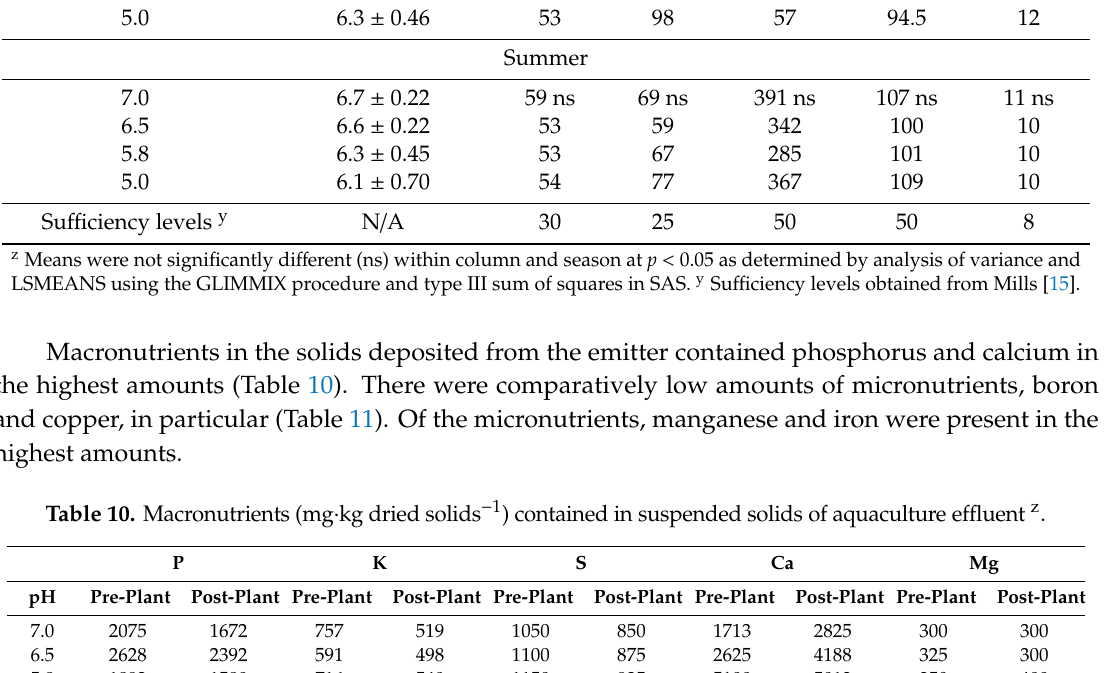
1892 z Solids were dried at 105 ◦ C for 24 h before analysis.